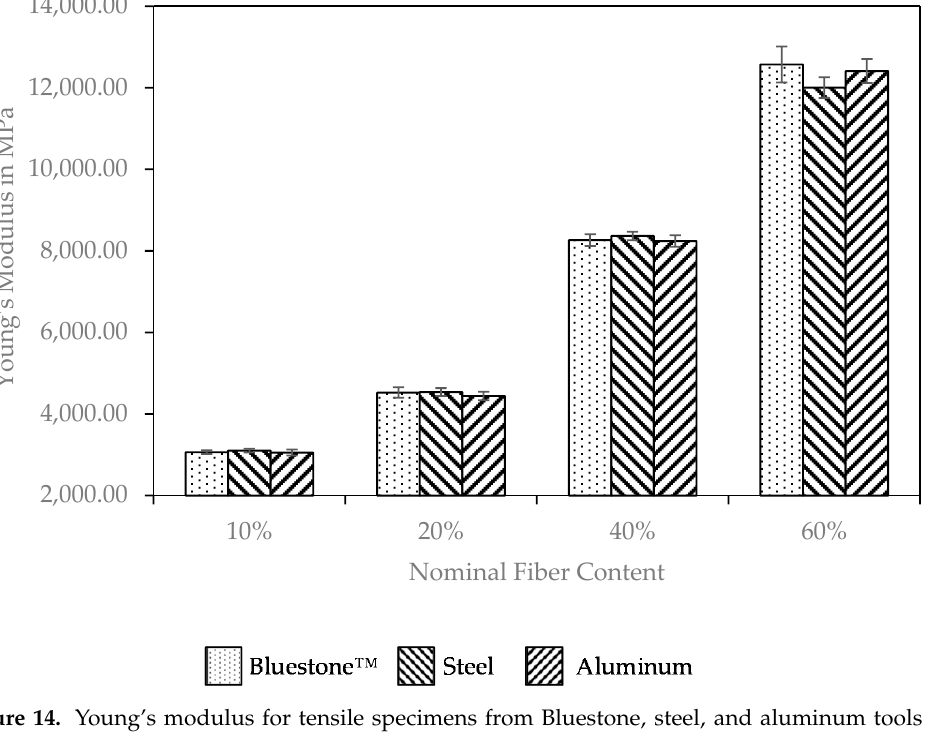
Figure 14. : Young’s Modulus for tensile specimens from Bluestone™ ‐ , Steel ‐ and Aluminum ‐ Figure 14. Young’s modulus for tensile specimens from Bluestone, steel, and aluminum tools for Tools for nominal fiber contents of 10, 20, 40 and 60 wt% nominal fiber contents of 10 wt.%, 20 wt.%, 40 wt.%, and 60 wt.%.